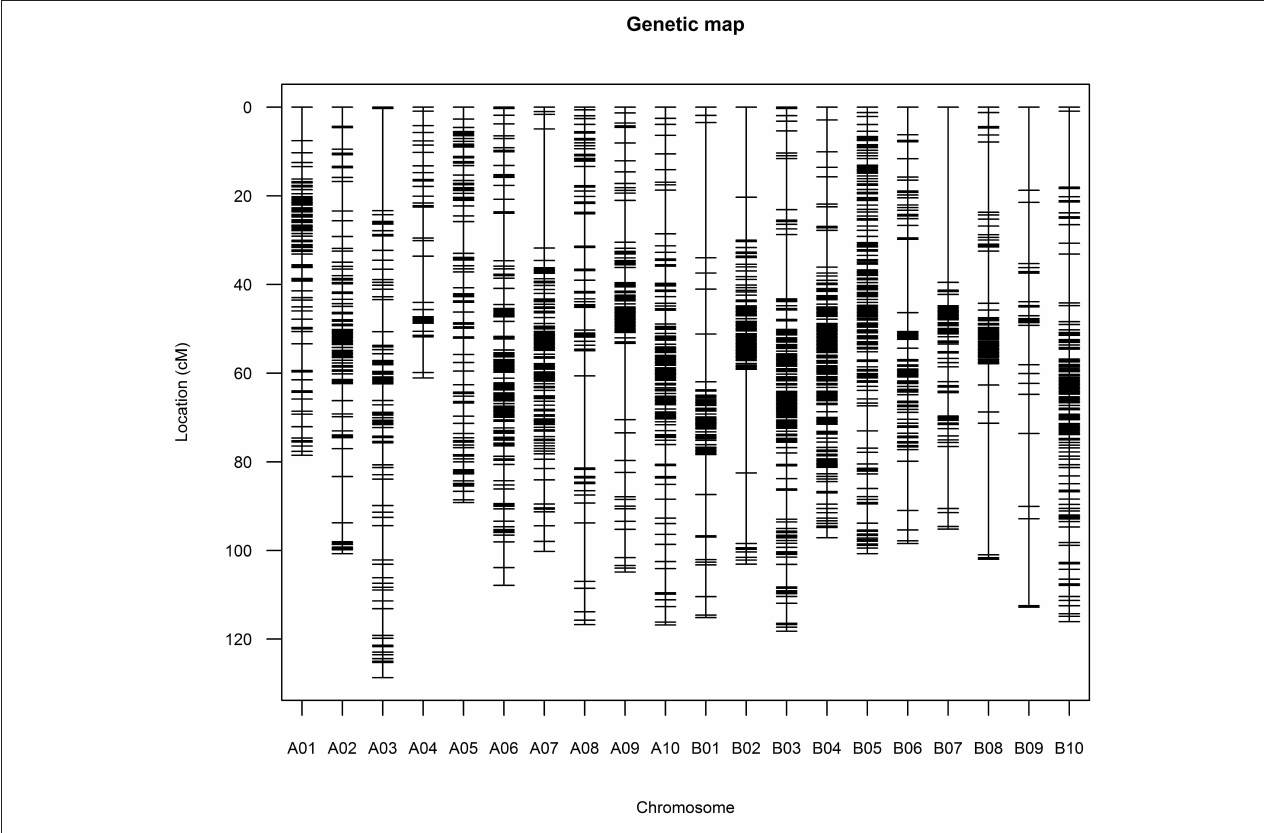
FIGURE 3 | Graph presentation of the constructed high-density genetic map.